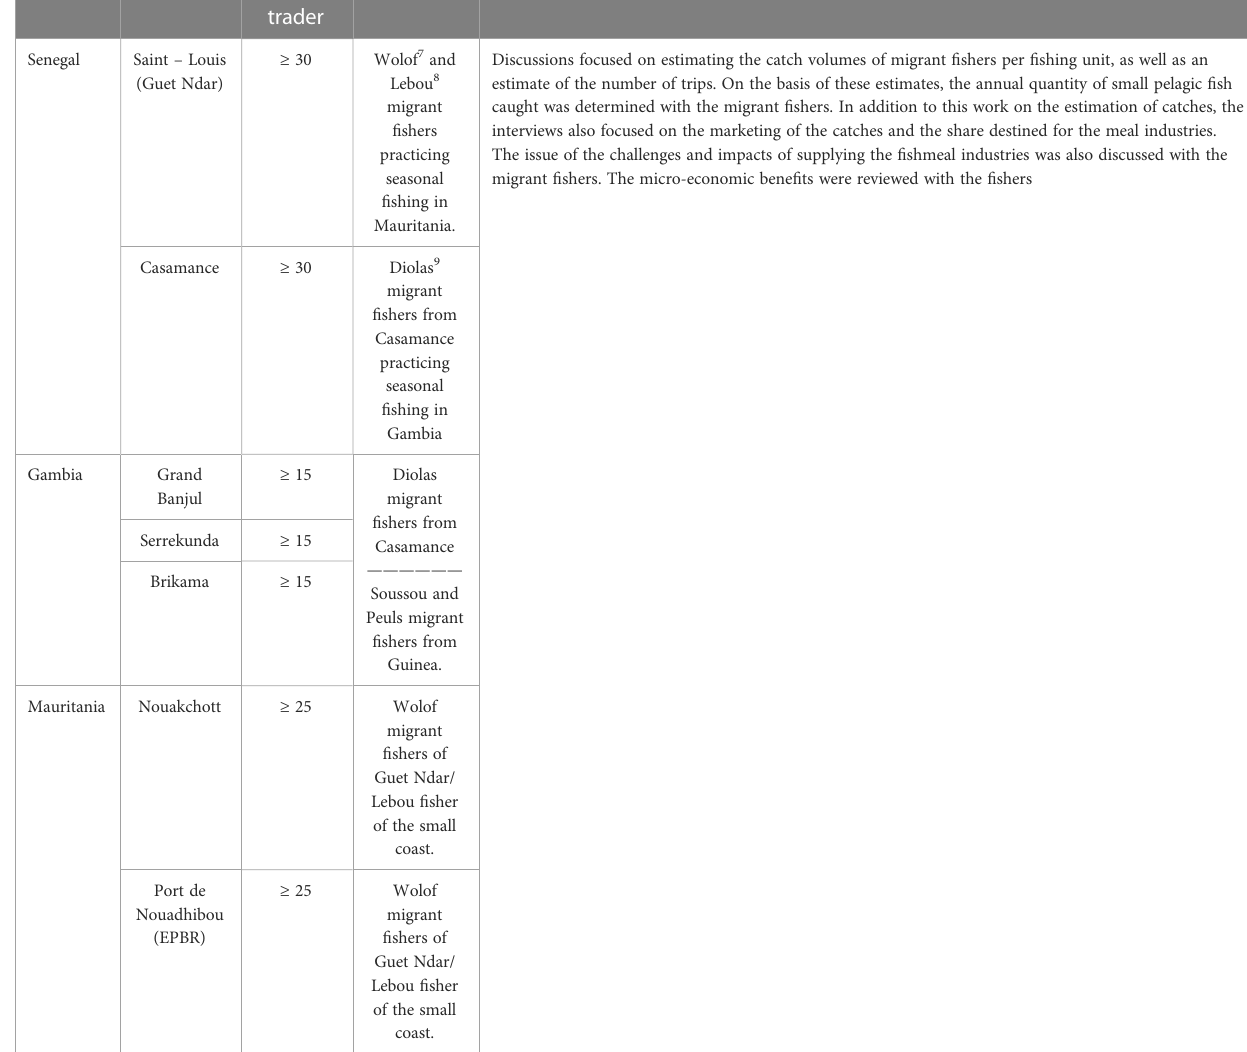
TABLE 1 Field survey process: research sites, number and pro fi les of actors interviewed, synthesis of the discussion. Actors